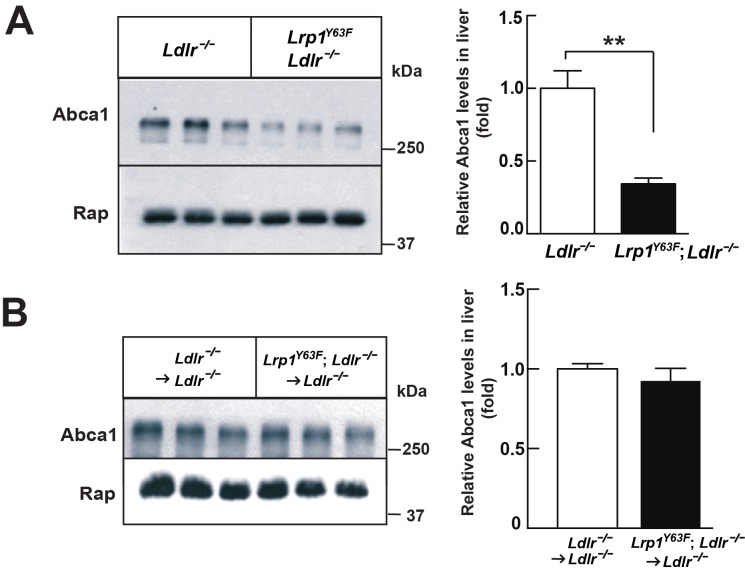
Lrp1Y63F mutation downregulates hepatic Abca1 levels.(A) Western blot analysis of Abca1 expression in the liver from Lrp1Y63F;Ldlr−/− and Ldlr−/− mice fed with HCHF diet for 16 weeks (n = 5, each group). (B) Western blot analysis of Abca1 expression in the liver from 16 week HCHF-fed Lrp1Y63F;Ldlr−/− and Ldlr−/− mice after BMT (n = 5, each group). All data are mean ±SEM. **p<0.01.